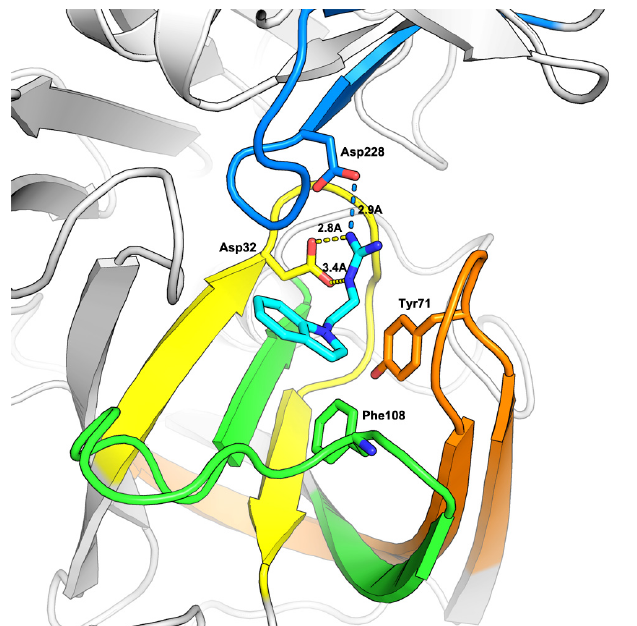
Figure 2. Docking study on compound 4 bound to BACE1. The coordinates of BACE1 was taken from the crystal structure of 1FKN. The protein is shown in cartoon, while the important residues and ligand 4 are shown in stick